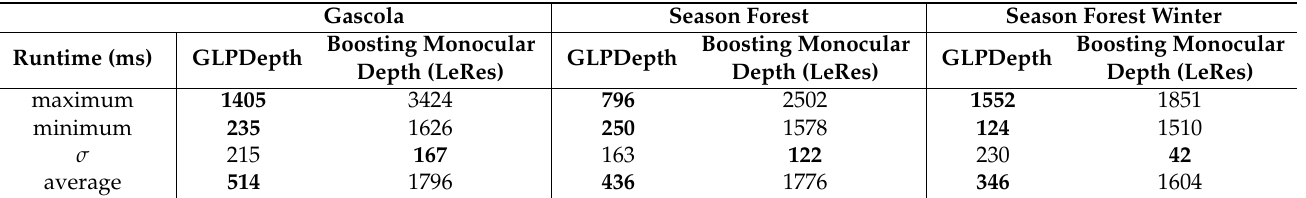
Table 7. Inference runtime comparison on the three trajectories (Gascola, Season Forest, and Season Forest Winter); the values in bold are the best results using GLPDepth and Boosting Monocular Depth